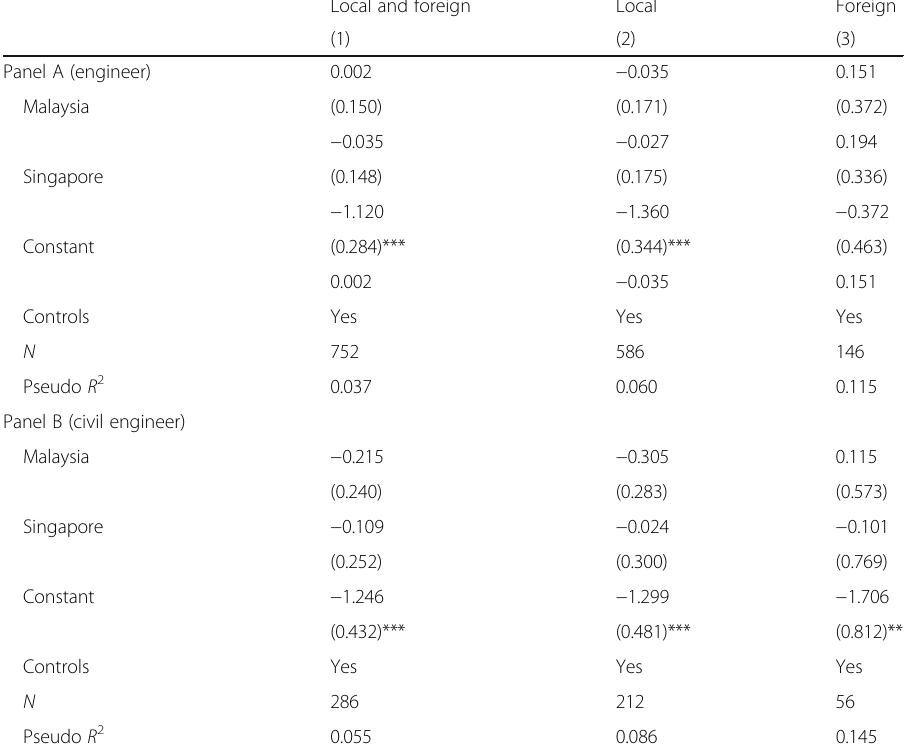
Table 16 Dependent variable: if a resume is the first to receive a callback for an interview (engineer) Local and foreign